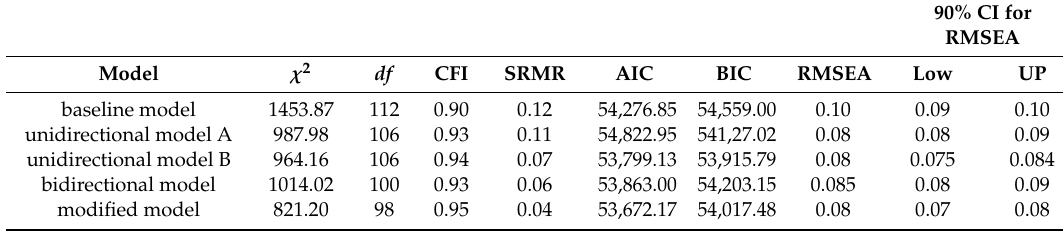
Table 5. Fit indices of models.